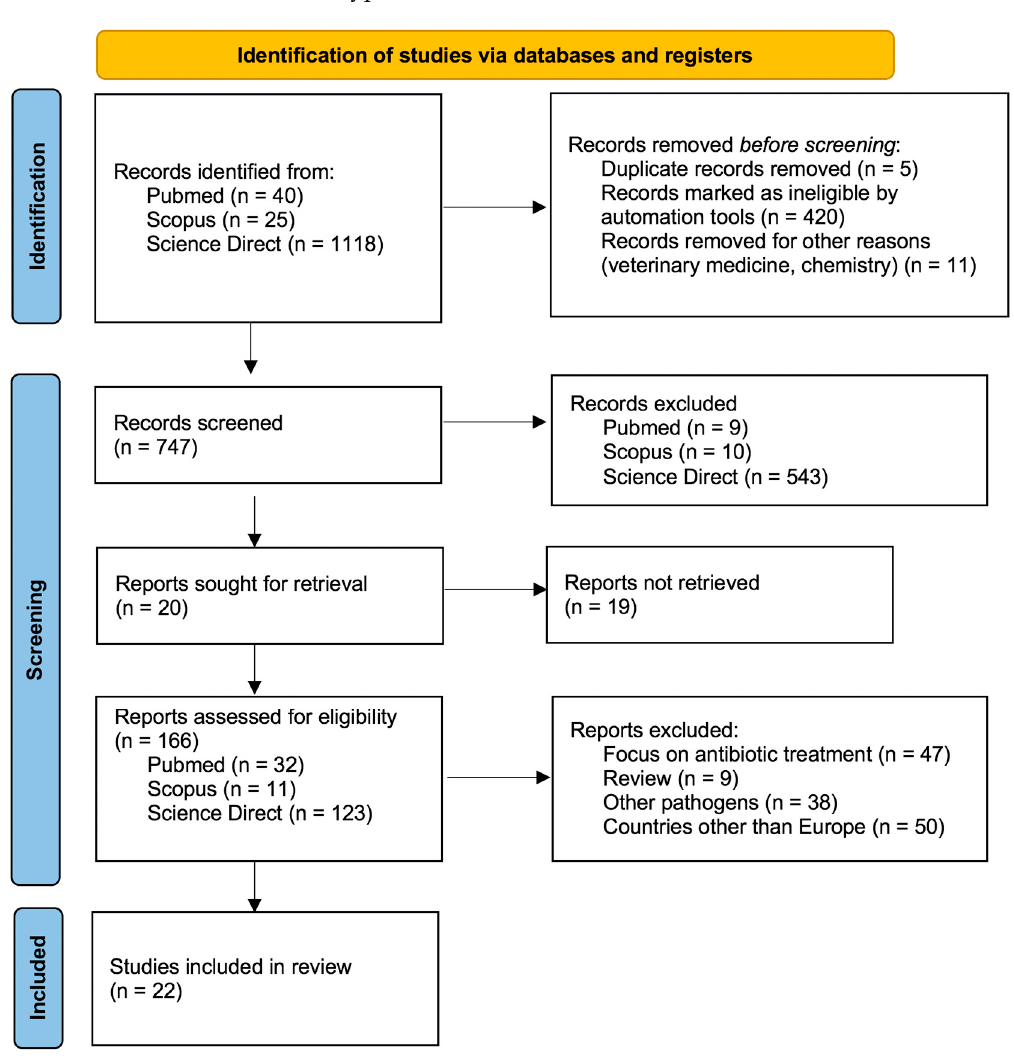
Figure 1. PRISMA flow chart. After removing duplicates and studies marked as ineligible by automation tools, 747 articles were screened by title and abstract. Irrelevant articles were excluded, and 20 ar- ticles were retrieved for full-text assessment. Of these, only one was suitable. Articles that focused on antibiotic treatments, studies conducted in countries other than in Europe or on pathogens other than MP, and reviews were excluded. Finally, 22 studies were in- cluded in the systematic review (Table 1). Table 1. Studies of the macrolide-resistant Mycoplasma pneumoniae (MR-MP) in Europe (2010–2021).